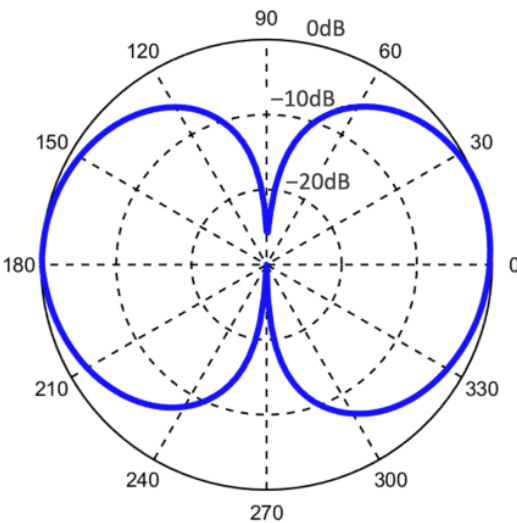
Figure 6. Measured directional response of the sensor mounted in the housing. The